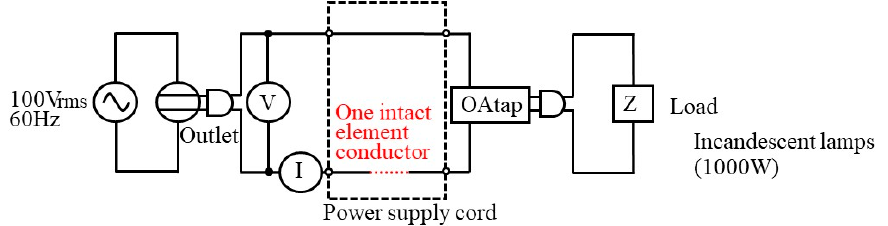
Figure 10. Experimental circuit for sample with one intact element conductor.